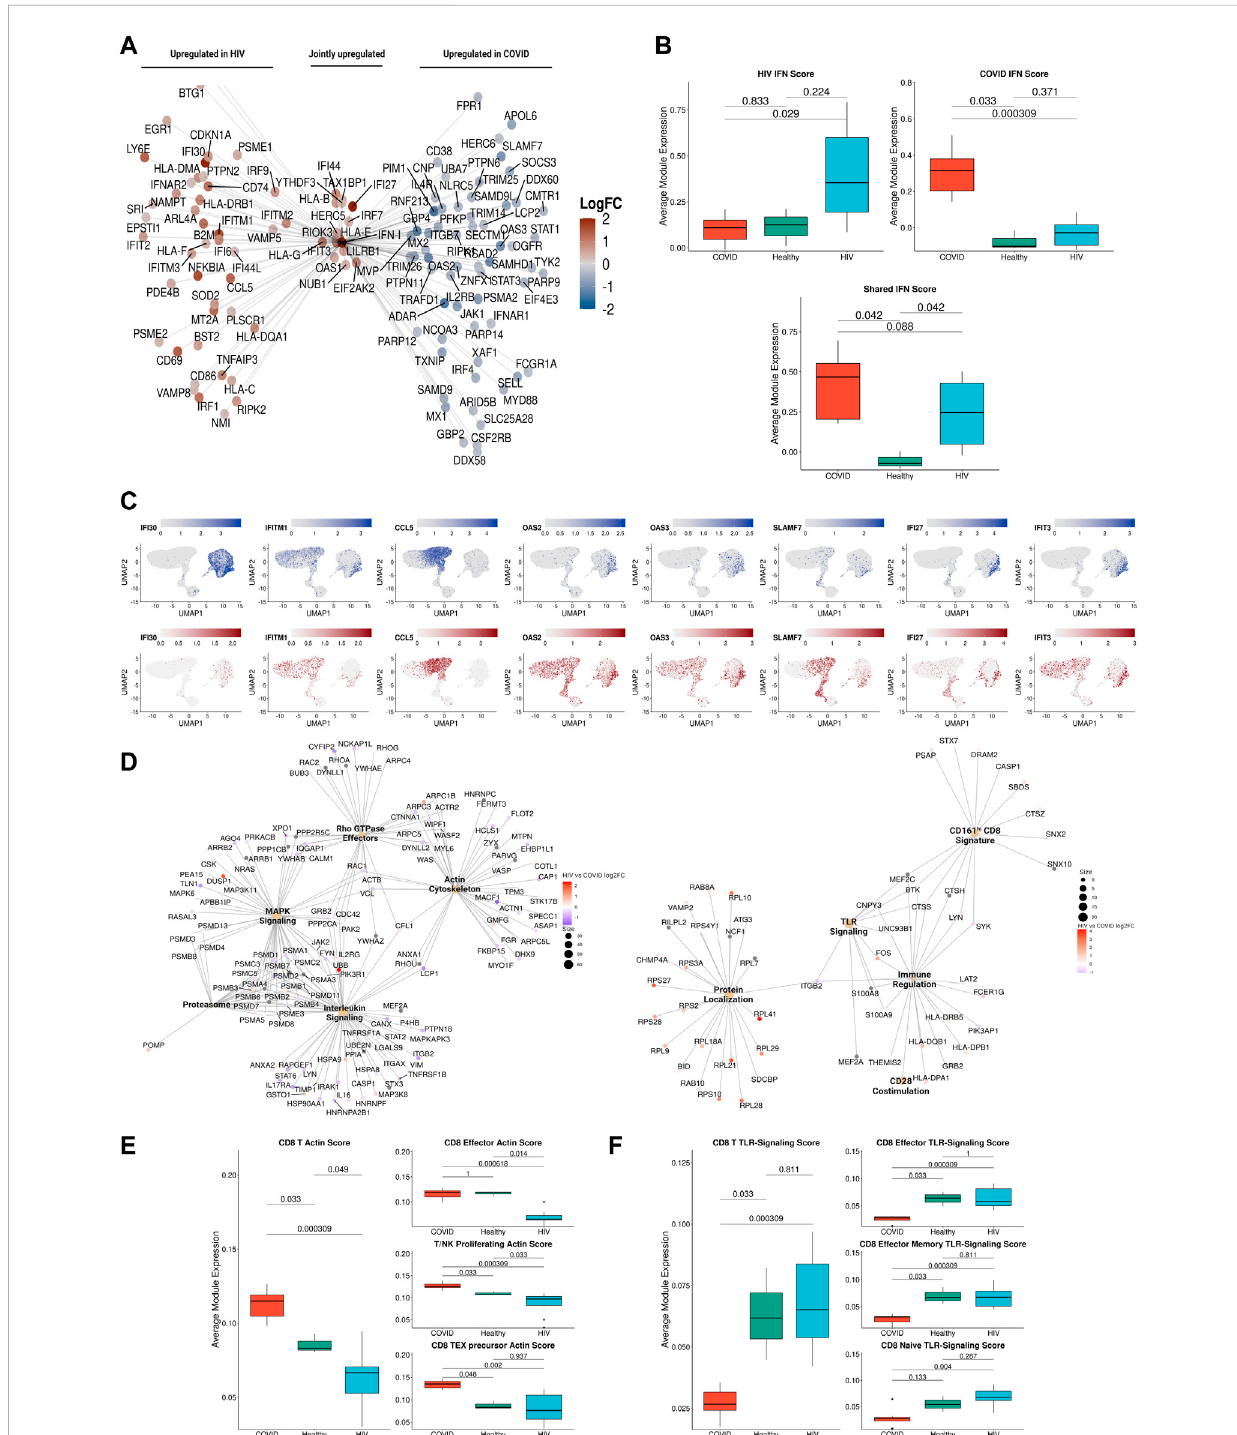
FIGURE 6 IFN-I signaling is correlated with divergent biological functions in COVID-19 versus HIV-1. (A) Network plot of genes related to IFN-I signaling that are differentially upregulated in COVID-19 (Right), HIV-1 (Left), or jointly upregulated compared to healthy controls. Genes are colored based on Log-2- fold change in expression in HIV-1 + versus COVID-19 patients. (B) Box plots of the average expression of HIV-1, COVID, and shared IFN-I module scores foreachcondition. p -valuesarecomputedwithWilcoxonsigned-ranktestwithHolm-Bonferroniadjustment. (C) Normalizedgeneexpressionplots of IFN-I genes in COVID-19 (top) and HIV-1 (bottom). (D) Network plot of key pathways correlated with IFN-I signaling in COVID-19 (left) and HIV-1 + patients (right). Size of each center corresponds to the number of genes present in the pathway. Genes are colored based on Log-2-fold change in expression in HIV-1 + versus COVID-19 patients. (E) Box plots of the average expression of CD8 + T cell actin polymerization module scores for each disease condition (left). Box plots of the average expression of CD8 + effector, T/NK proliferating, and CD8 + Tex precursor scores for each